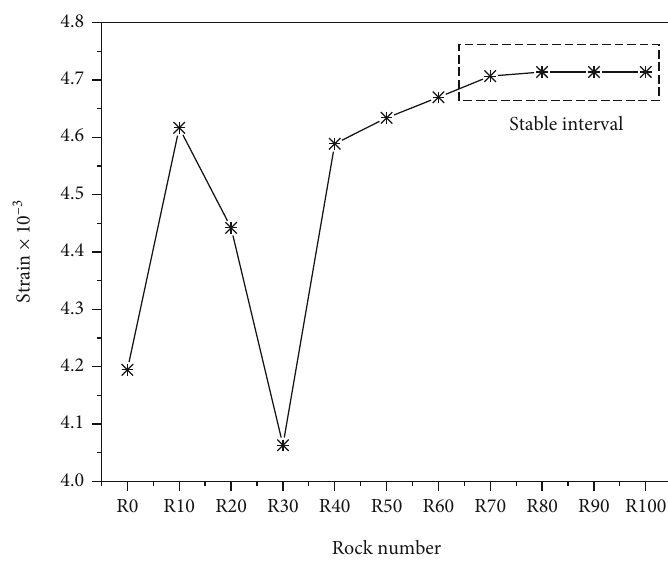
Figure 14: Peak strain-CRV curve.